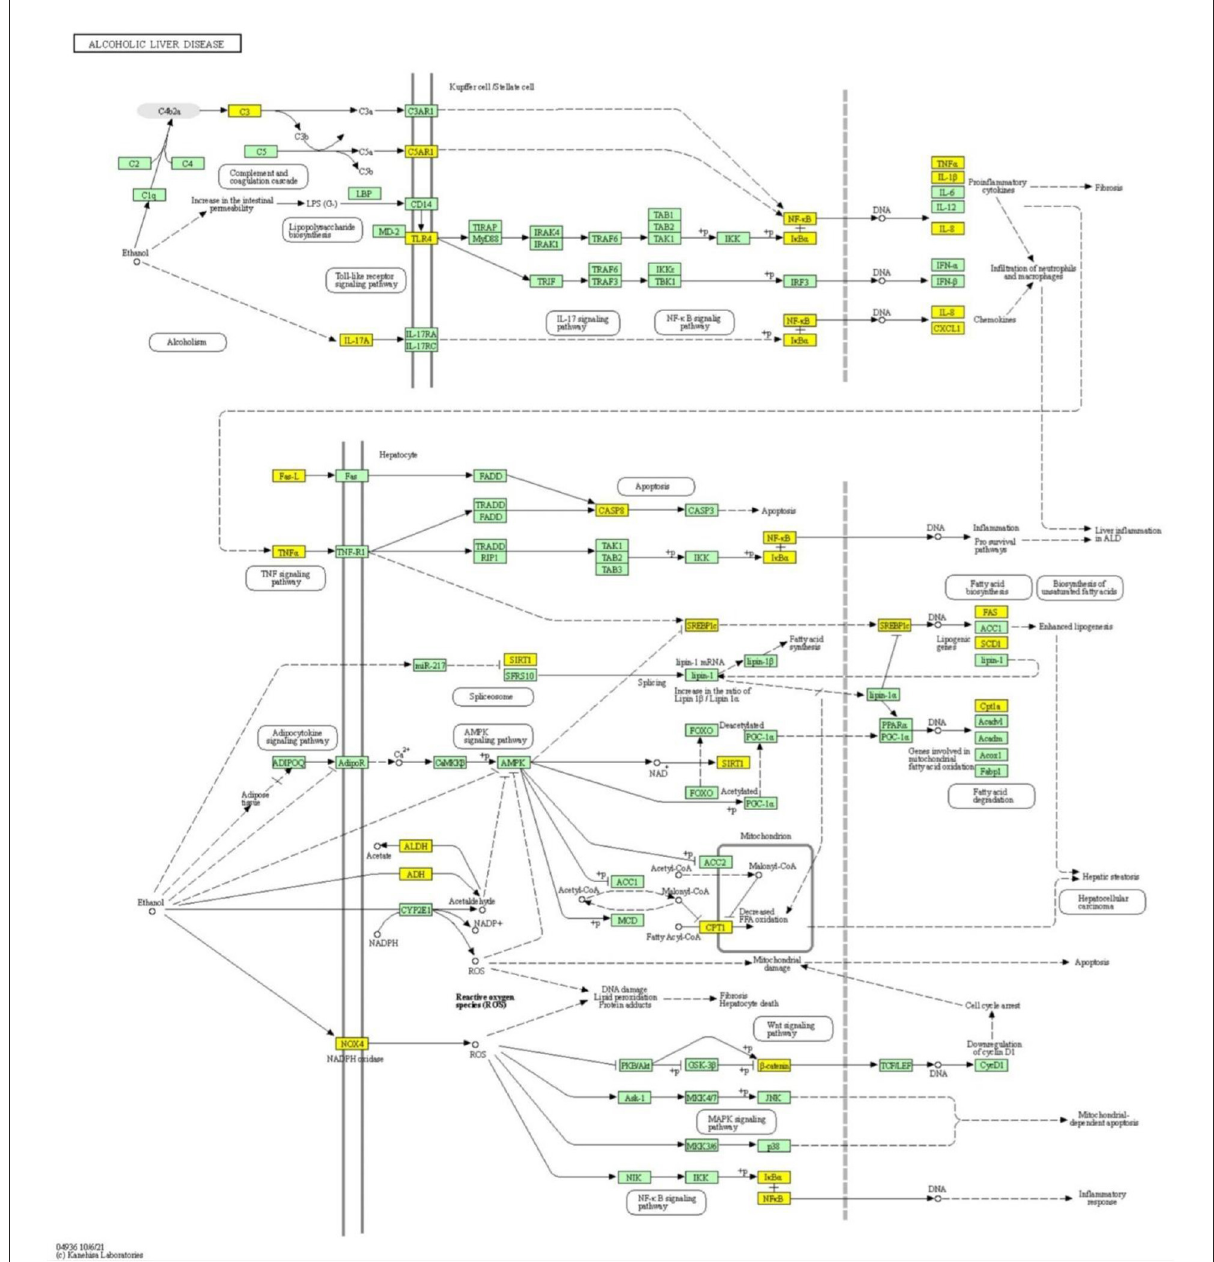
FIGURE6 Pathway mapping of the TC protein targets in the ALD pathway. Mapping of the protein targets location of TC in the ALD pathway. The mapped proteins are highlighted in yellow boxes.